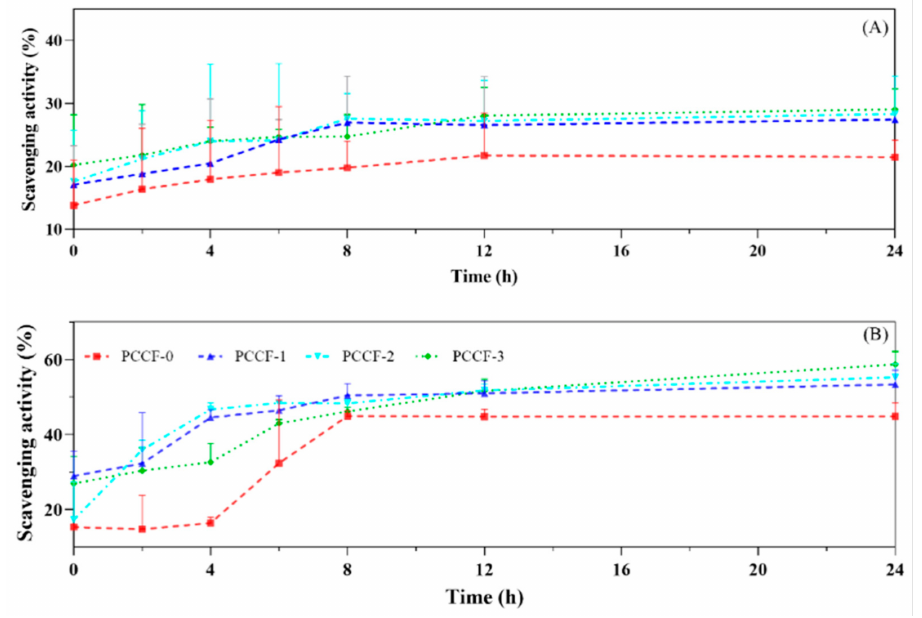
Figure 6. Antioxidant activity of PCCF ( A ) ABTS free radical scavenging activity; ( B ) DPPH free radical scavenging